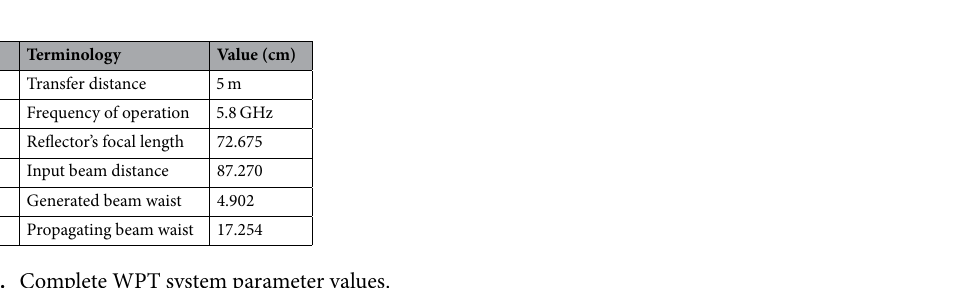
Table 4. Complete WPT system parameter